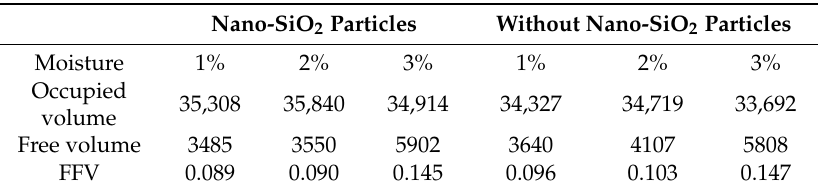
Table 2. Summarizes the free volume fractions of models having different water contents (Å 3 ). FFV: fractional free volume.